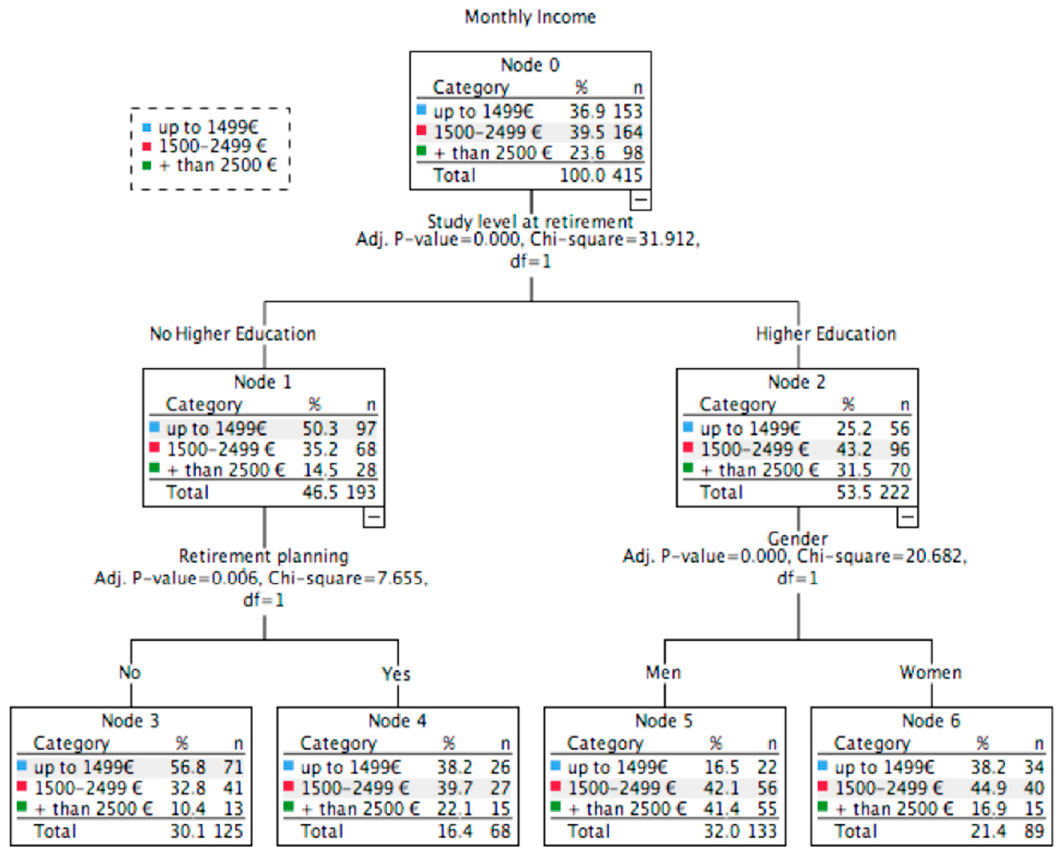
Figure 2. Classification tree analysis of monthly income for elite athletes.